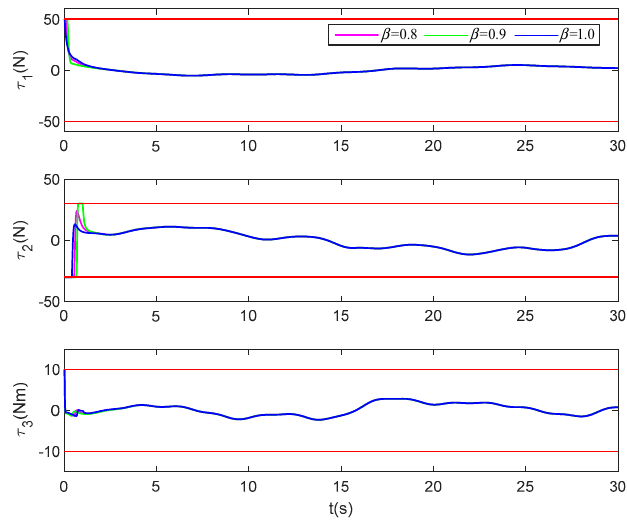
Figure 16. Control input under different orders. (3) Comparison of observation effects from different